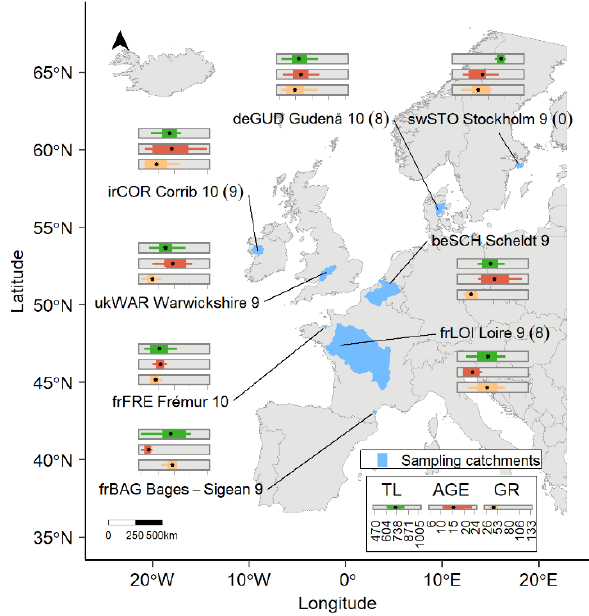
Figure 1. Sampling sites throughout Europe. For each catchment, the identifier (related to Table 1), the full name, the number of eels (in brackets: number of eels for the 11-ketotestoterone trait, if different) and the boxplots of total length (TL, mm), age (year) and growth rate (GR, mm · year − 1 ) are displayed. Catchment area is displayed by blue shading. Table 1. Details of sampling sites.